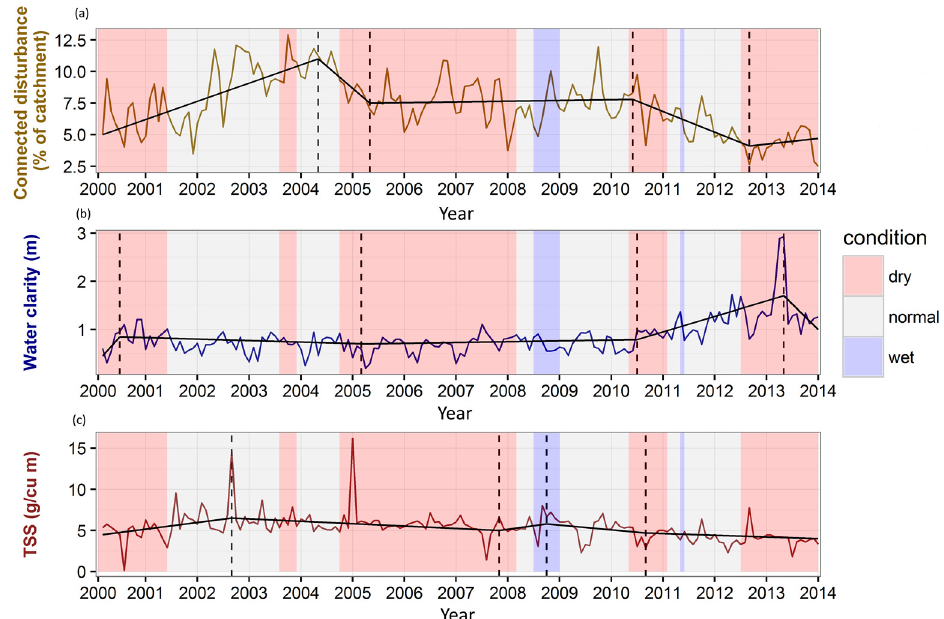
Figure 6. Monthly ( a ) percentage of catchment connected and disturbed; ( b ) water clarity (residuals from local polynomial regression (LOESS) + mean clarity; and ( c ) flow-adjusted TSS (residuals from loess + mean TSS) for the period 2000–2013. The timing of breakpoints (dashed lines) between connected disturbance and water clarity from 2005–2013 seem to coincide, suggesting a cause and effect relationship between the two. Wet (blue), normal (grey), and dry (red) periods were calculated from a 12 month standardized precipitation index (SPI). The segmented regression lines are shown in black.